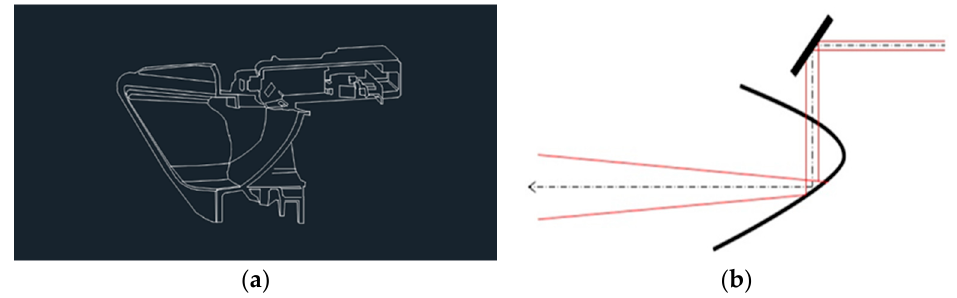
Figure 1. ( a ) BMW i8 laser headlight and ( b ) its schematic diagram of light tracks.